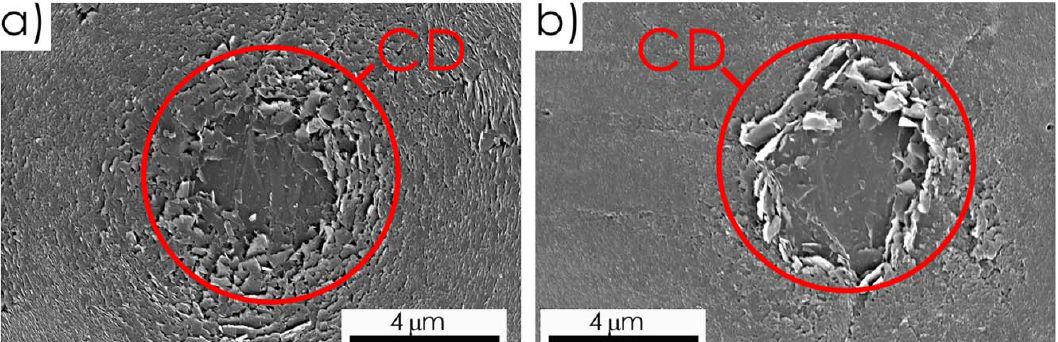
Figure 3. Morphology of area of the initial stage of graphite spheroid destruction, the central disgregation (CD), SEM: ( a ) At a distance of 3 mm from fracture surface, specimen SNi11, ( b ) at a distance of 1 mm from the fracture surface, specimen austempered ductile iron (ADI)390.